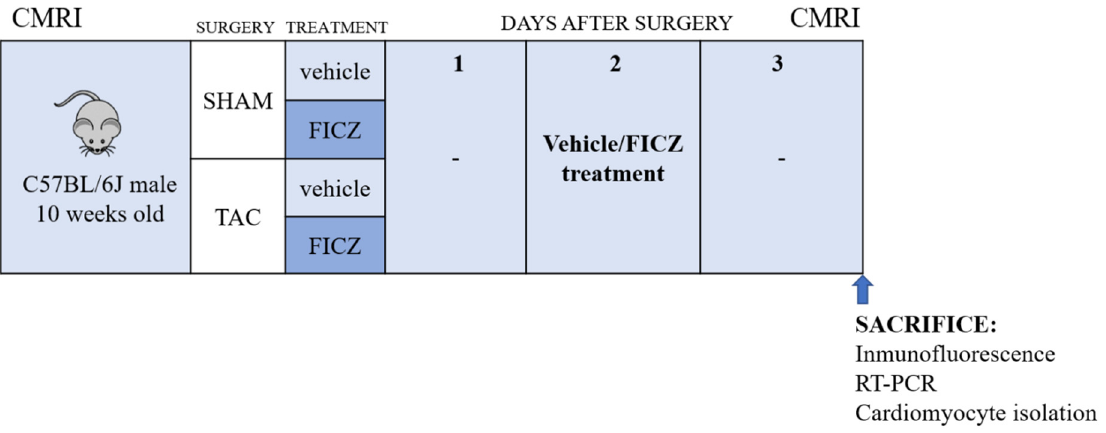
Figure 8. Scheme of the study design.